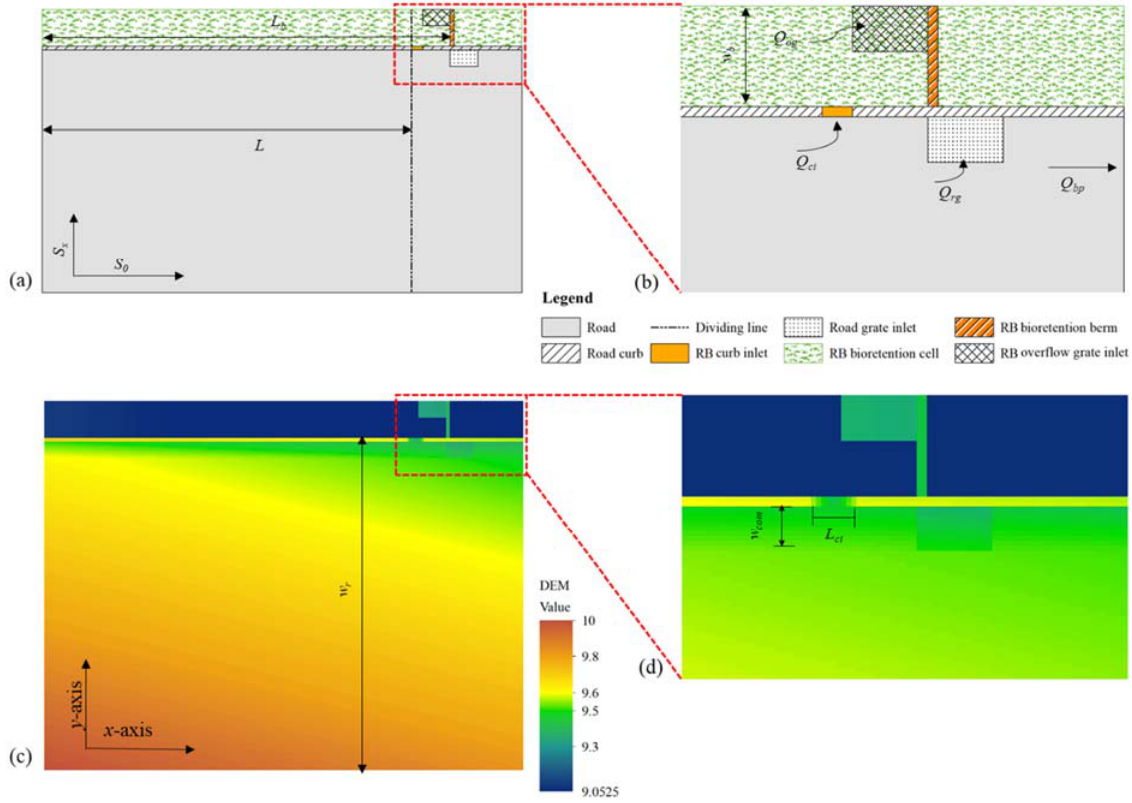
Figure 3. Full and zoomed-in view for simulation domain ( a , b ) and corresponding digital elevation models (DEMs) ( c , d ). ( c , d ) is for composite depressed Case 01 (Table 2). Q ci is the curb inlet intercepted flow, Q rg for road grate inlet captured flow, Q bp for road end bypass flow, and Q og for the bioretention grate inlet overflow. L and w r are the road surface length and width upstream the curb inlet. L b and w b are the road-bioretention (RB) stripe length and width. w com is the width for the composite slope (Figure 1c). Table 1. Design parameters for RB stripes.